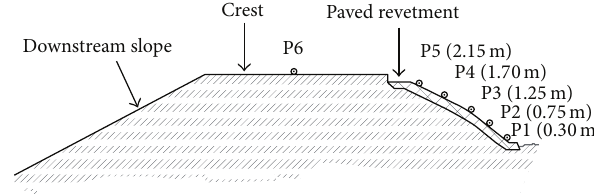
Figure 4: Transverse cross section of the embankment and location of the GPR profiles on the sloped paved revetment (P1 to P5) of the canal and on its crest (P6).